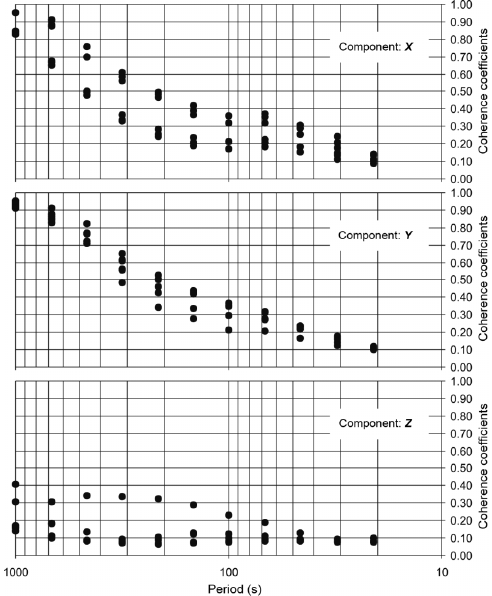
Fig. 3. Mean coherence coefficients calculated for stations SSL, GRN, RDK,